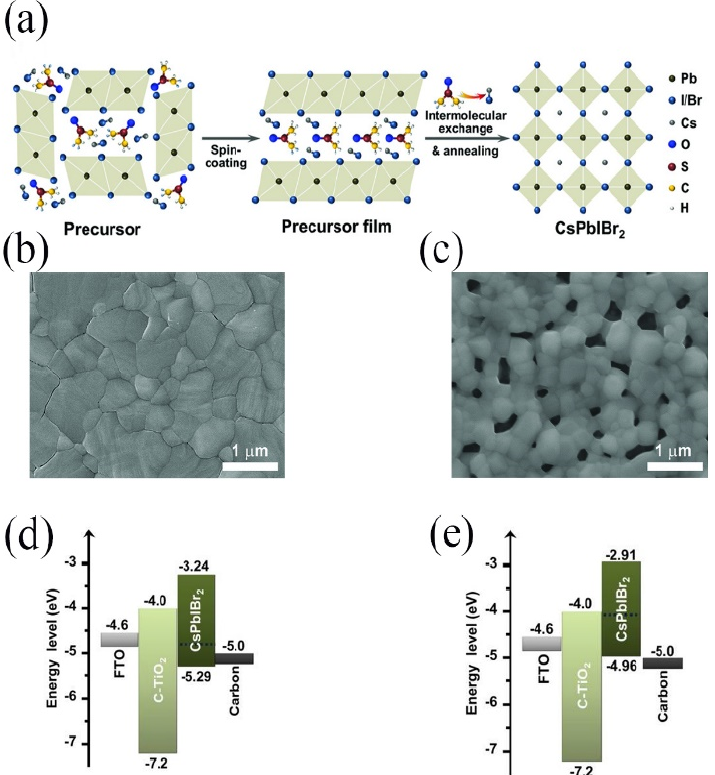
Figure 4. ( a ) Illustration of intermolecular exchange approach for CsPbIBr 2 film fabrication. SEM images of CsPbIBr 2 films obtained by ( b ) intermolecular exchange and ( c ) conventional one-step solution. ( d ) Energy level diagrams of CsPbIBr 2 films fabricated by intermolecular exchange and ( e ) conventional route. Reproduced with permission [50]. Copyright 2018, Wiley-VCH Publications.